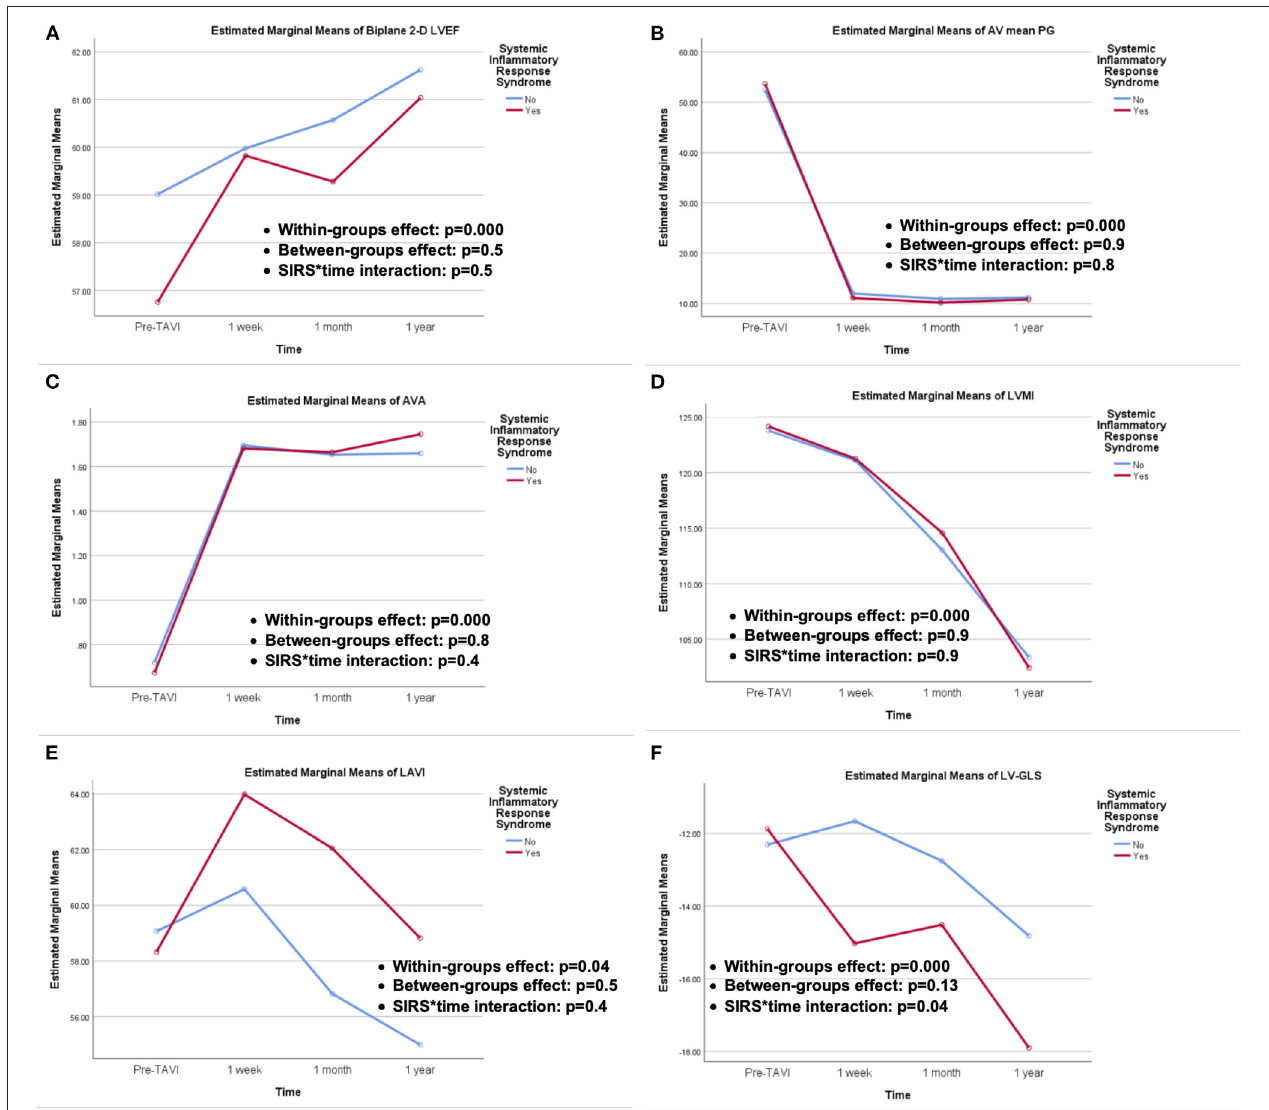
FIGURE 1 | Repeated measures ANOVA for echocardiographic outcomes of; (A) 2-D LVEF, (B) AV mean PG, (C) AVA, (D) LVMI, (E) LAVI, and (F) LV-GLS, showing the within-groups and between-groups effect, as well as SIRS groups and time